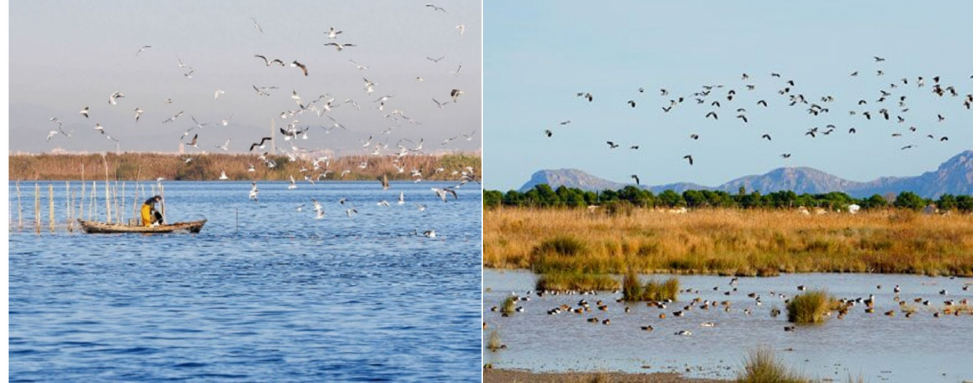
Figure 6. Comparison of the water level in the Albufera of Valencia at different times of the